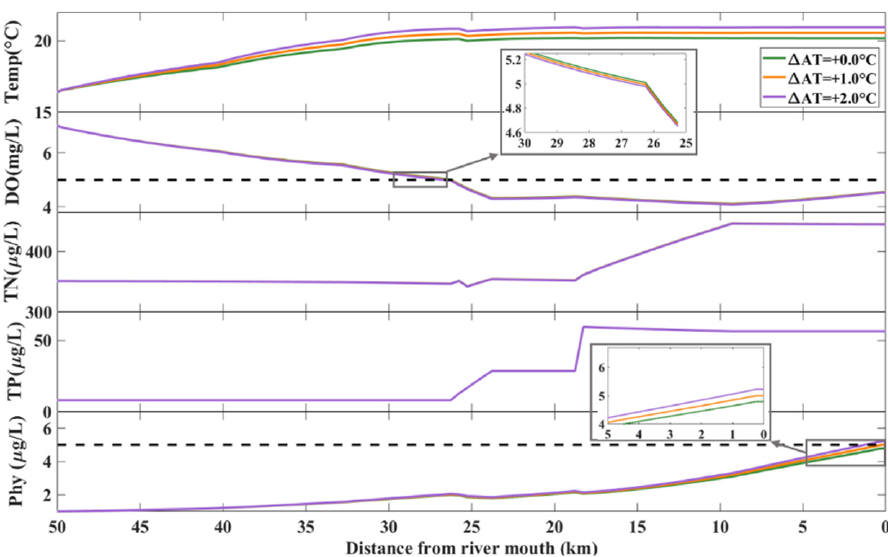
Figure 5. Water temperature/DO/TN/TP/phytoplankton concentrations along the Shoalhaven River with the incremental increases Δ AT in air temperature from 0 °C to 2 °C but under 2017 air temperature and streamflow conditions. The black dashed line in the DO concentration is the minimum acceptable level of 5 mg/L, and the black dashed line in the phytoplankton concentration is at 5 µ g/L, which is the phytoplankton concentration threshold for an algal bloom (the same is below in Figures 6 and 7).